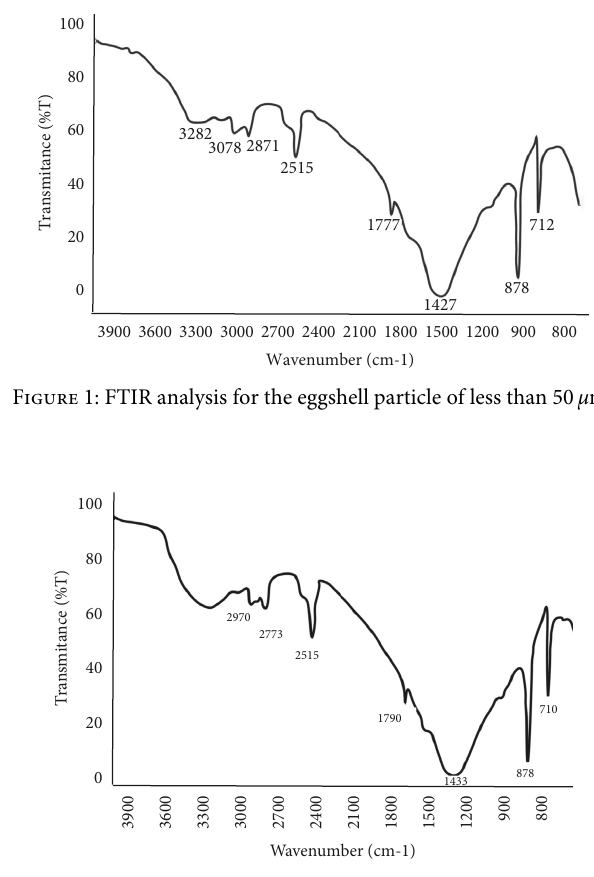
Figure 2: FTIR analysis for the eggshell powder of a particle size of 150 μ m.